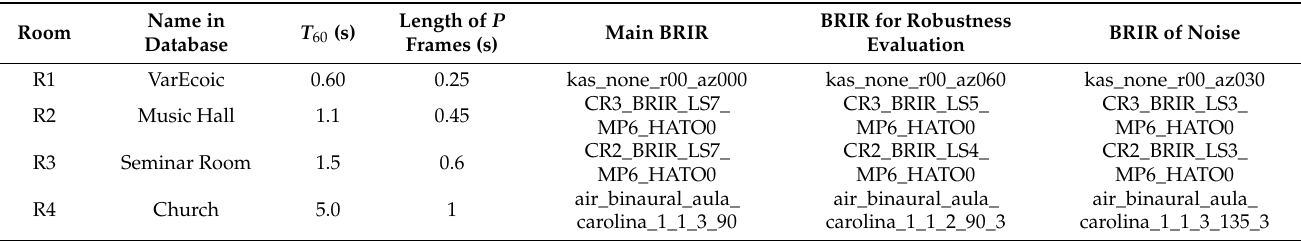
Table 1. The BRIRs used for the optimization and subjective evaluation. The room names in the database, reverberation times, the length of P frames, and selected BRIRs are